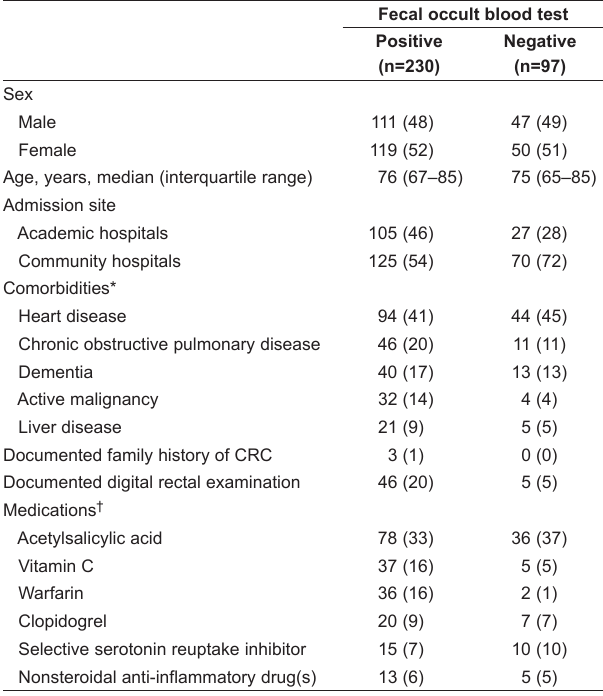
TAble 1 Description of positive and negative fecal occult blood test patients